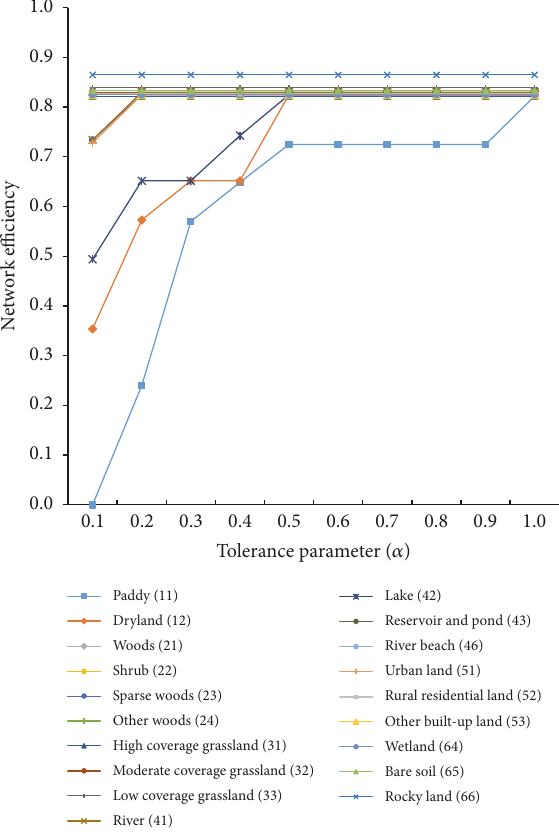
Figure 7: Network efficiency versus different tolerance parameter (area shrinkage due to attack is set as